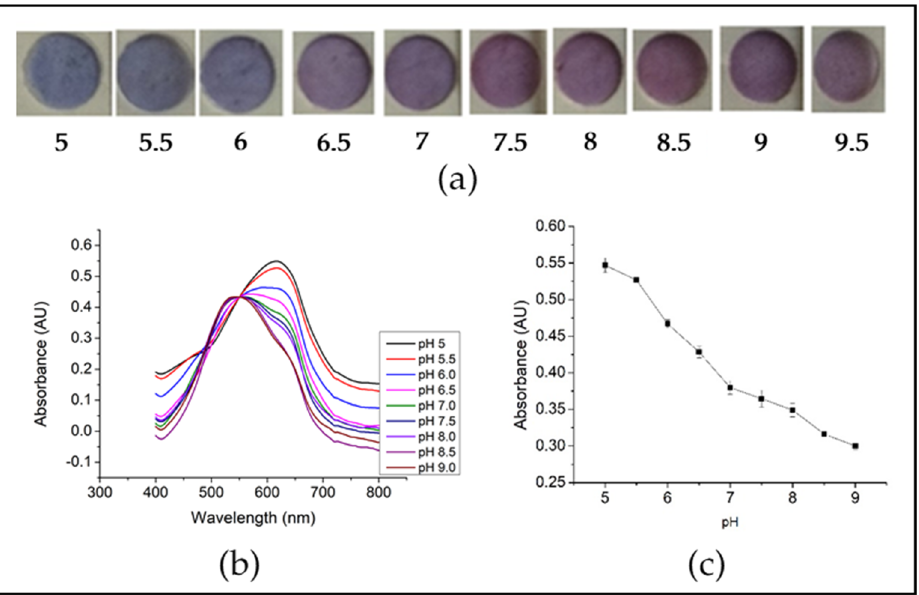
Figure 5. The visual appearance of pH sensor (a) and UV-Vis spectral profile of the manufactured optical pH sensor (b). Sensor response with respect to pH changes from pH 5 to 9 (c).